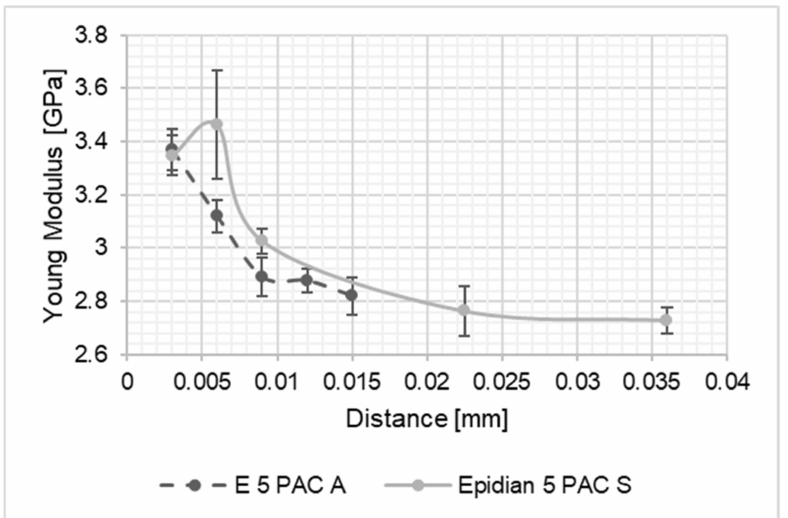
Figure 4. Comparison of Young’s modulus values for the Epidian 5/PAC joint bonding: A—EN-AW 2024-T3 aluminium alloy sheets; S—1.4301 stainless steel sheets.